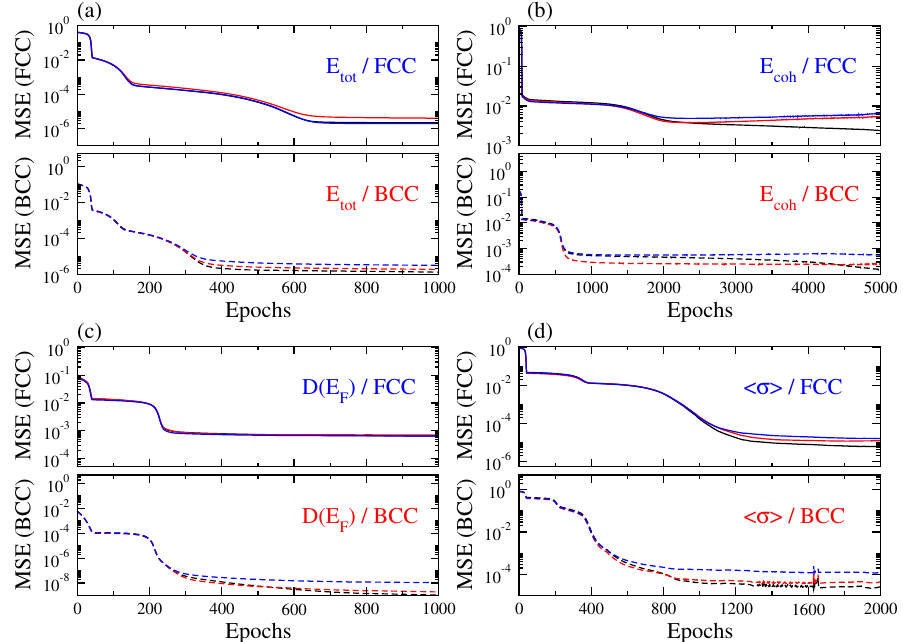
Figure 5. The loss functions (mean squared error) for training, validation and test, in correspondence with r 2 coefficients presented in Figure 4a–d. Overtraining effects are visible in the ( b ) sub-plot, mapping cohesive